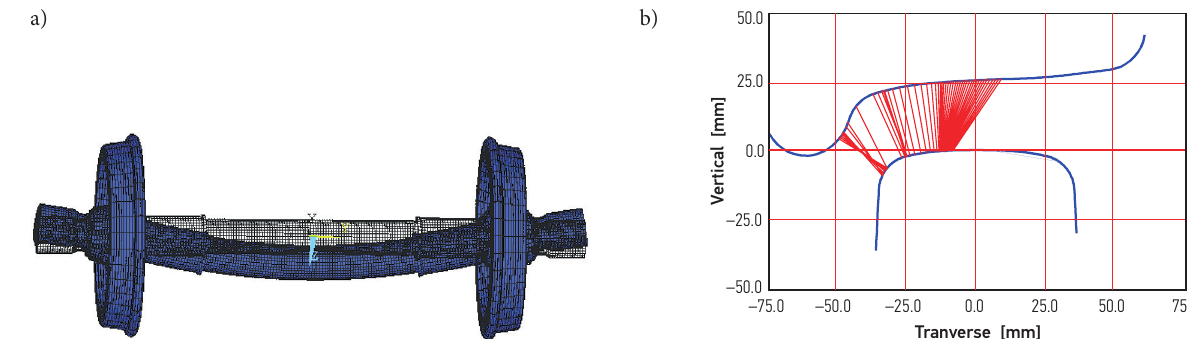
Fig. 4. The elastic wheelset model and the wheel / rail contact geometry: a – elastic wheelset model; b – wheel / rail contact